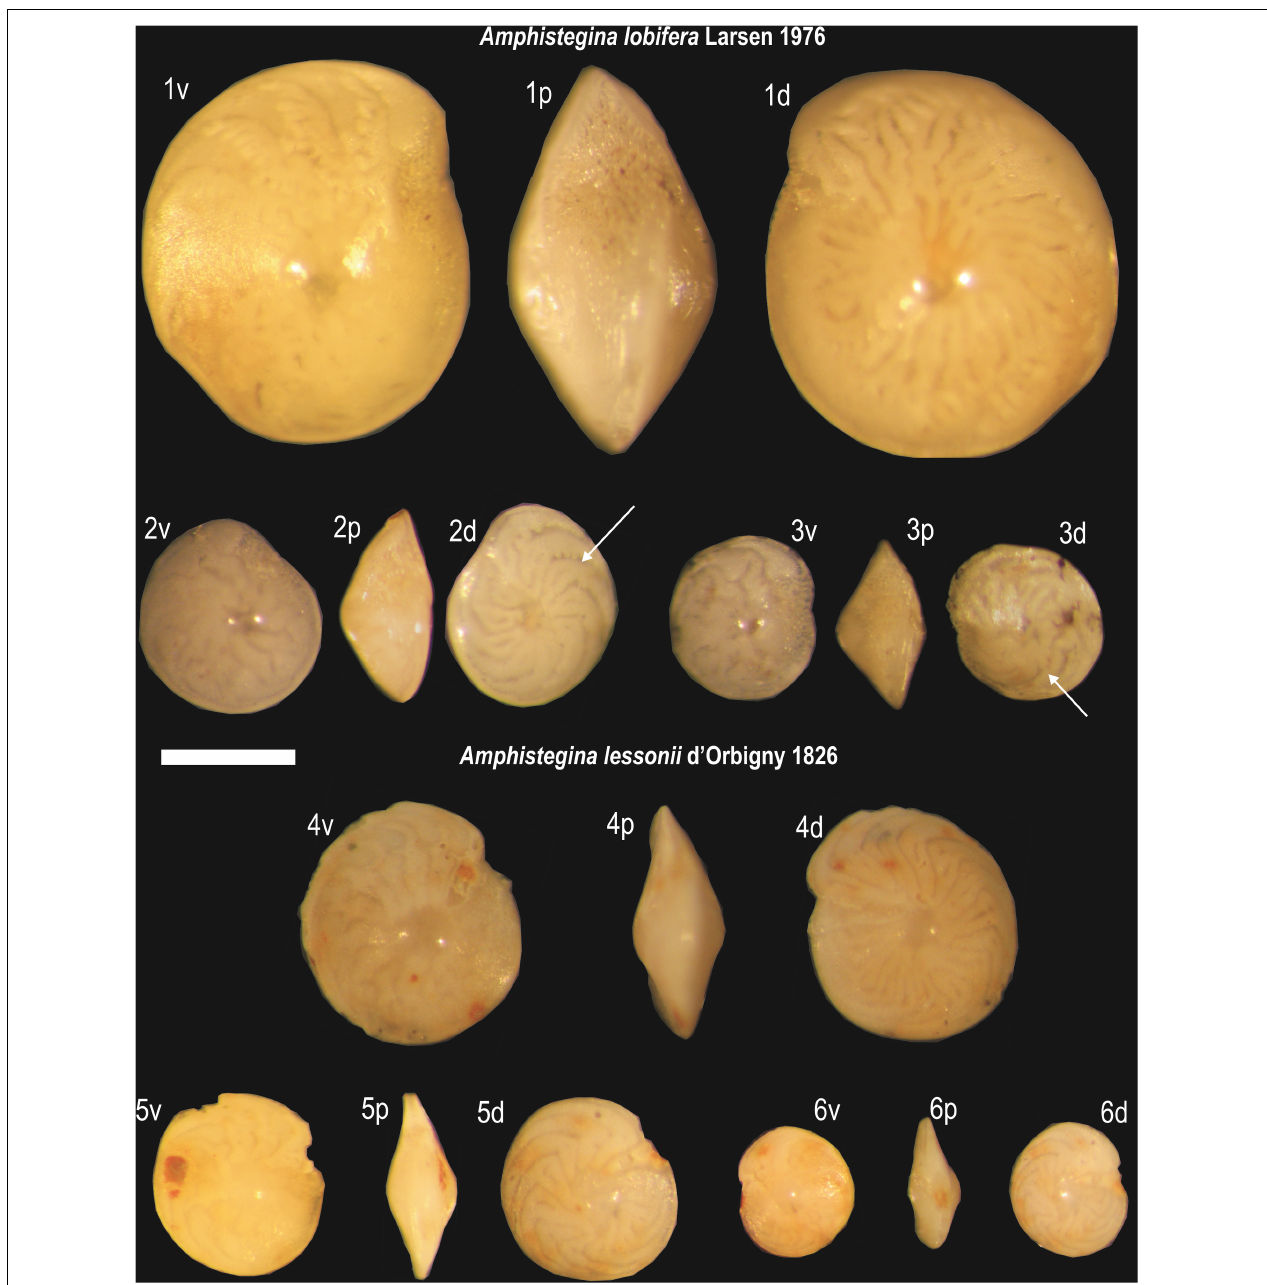
FIGURE 2 | Photomicrographs of adult and juvenile specimens of Amphistegina lobifera (images 1–3) and Amphistegina lessonii (4–6) collected from cm 2 to 3 bsf of CORE19. v) ventral view; p) profile; d) dorsal view. Note in juvenile specimens of A. lobifera (diameter size < 300 µ m, images 2–3) the presence of typical lobulated sutures (arrows) and the more rounded profile with respect to juvenile specimens of A. lessonii (5–6) characterized by more flattened tests with falciform sutures without any folding nor complication. Scale bar 300 µ m.